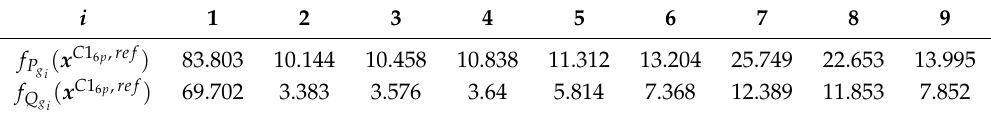
Table 4. Values of the 18 indices produced by x C 1 6 p , ref